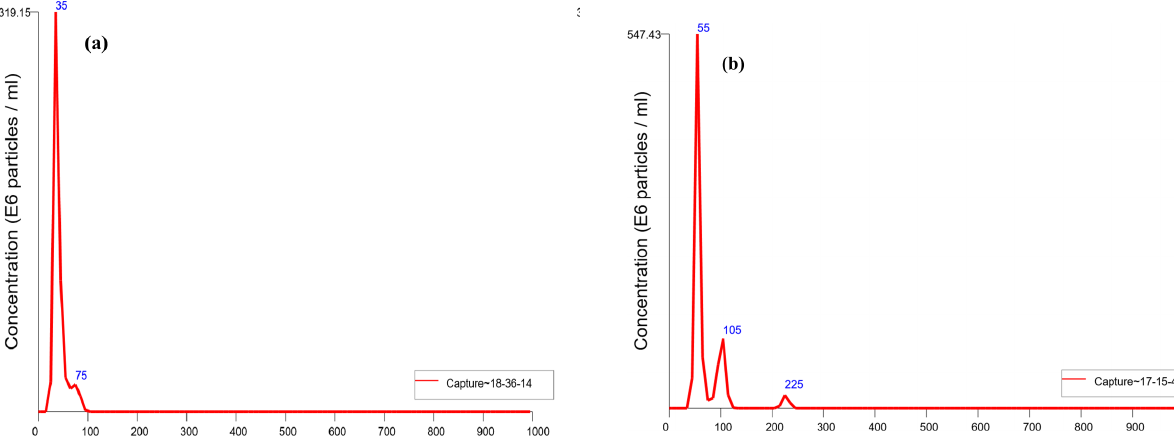
Figure 2. Particle size distributions curve of synthesized nanoparticles determined by DLS analysis (a) coated NPs, (b) uncoated NPs